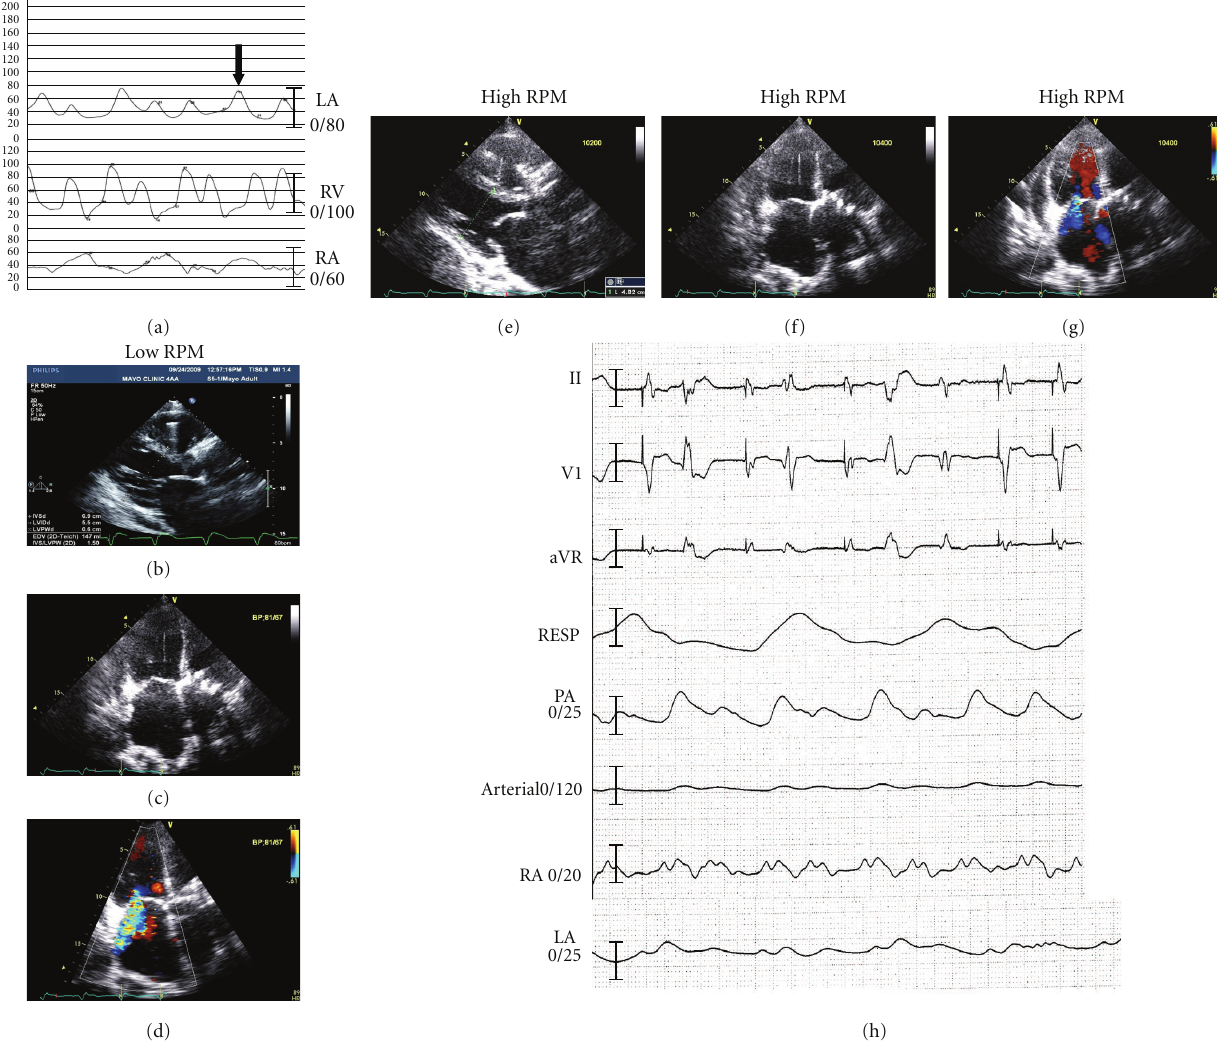
Figure 3: Severe functional mitral regurgitation. A patient presenting 17 months after LVAD implantation with failure to thrive and advanced right- and left-sided heart failure. (a) Hemodynamic right heart catheterization revealed markedly increased wedge and right atrial and ventricular pressures. Left atrial V wave (black arrow) reaching up to 70mmHg was recorded suggesting significant functional mitral regurgitation. Echocardiographic examination during baseline RPM settings showed increased LV diameter (a), interventricular, interatrial septa shifted to the right, increased mitral annular diameter and tenting diameters (b), and severe functional mitral regurgitation. Left ventricular assist device speed was increased under echocardiographic guidance. Left ventricular middiameter decreased in size (e). Interventricular, interatrial septa shifted to the left and mitral annular and tenting diameters decreased in size (f). Functional mitral regurgitation severity decreased significantly (g). Right heart catheterization in the end of echocardiographic examination showed normal wedge, right ventricle, and right atrial pressures, and no V waves (h). Notably, cardiac output increased from 5.7 to 7.2 liters/minute after LVAD